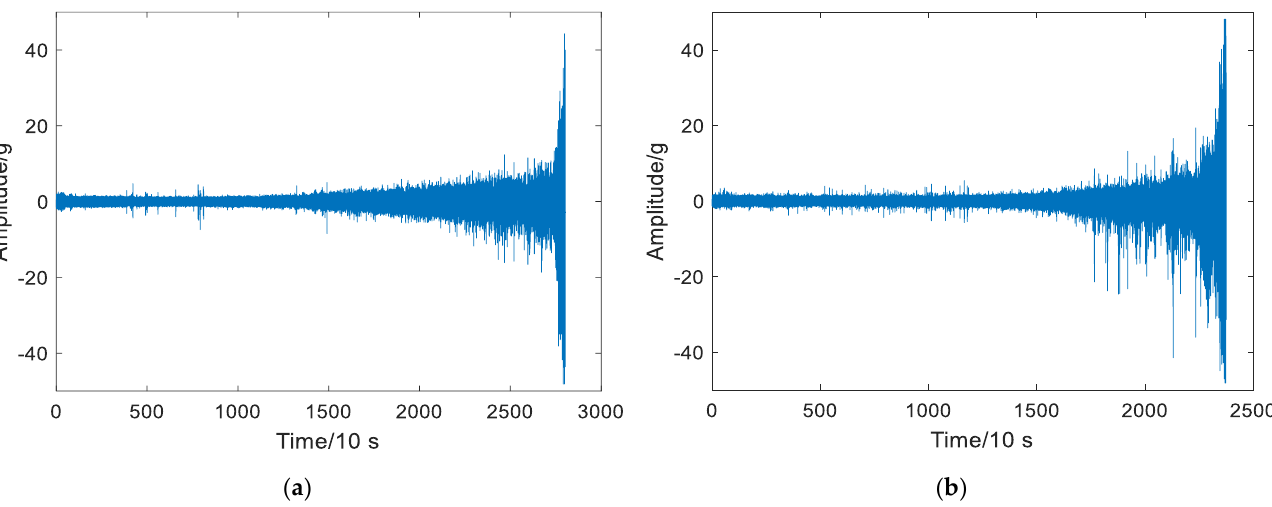
Figure 7. Time domain signal waveforms of bearing 1 − 1 and 1 − 3. ( a ) Time domain waveform of bearing 1 − 1; ( b ) time domain waveform of bearing 1 − 3.